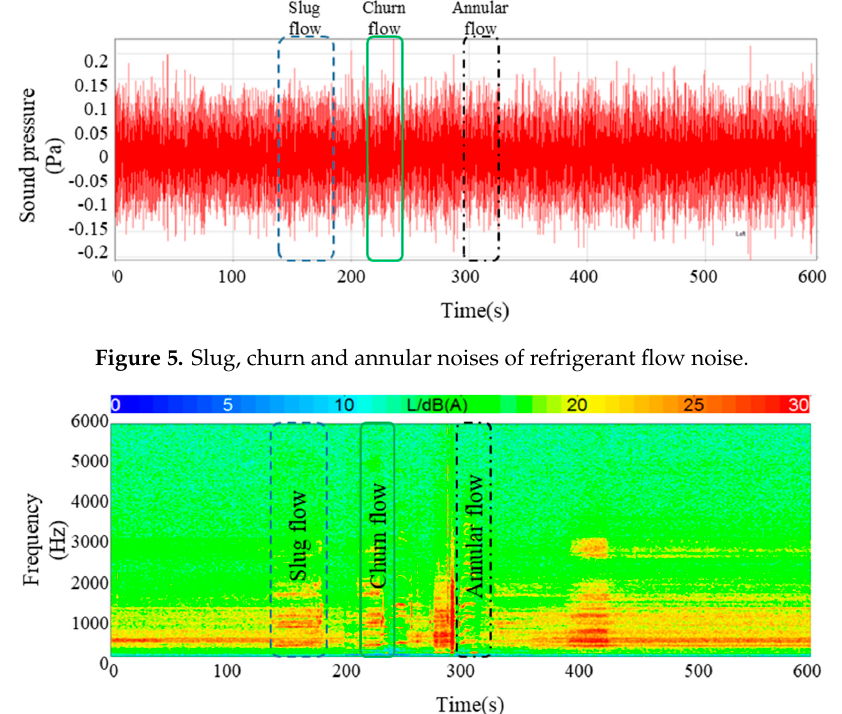
Figure 6. Time-frequency analysis of refrigerant flow noise.